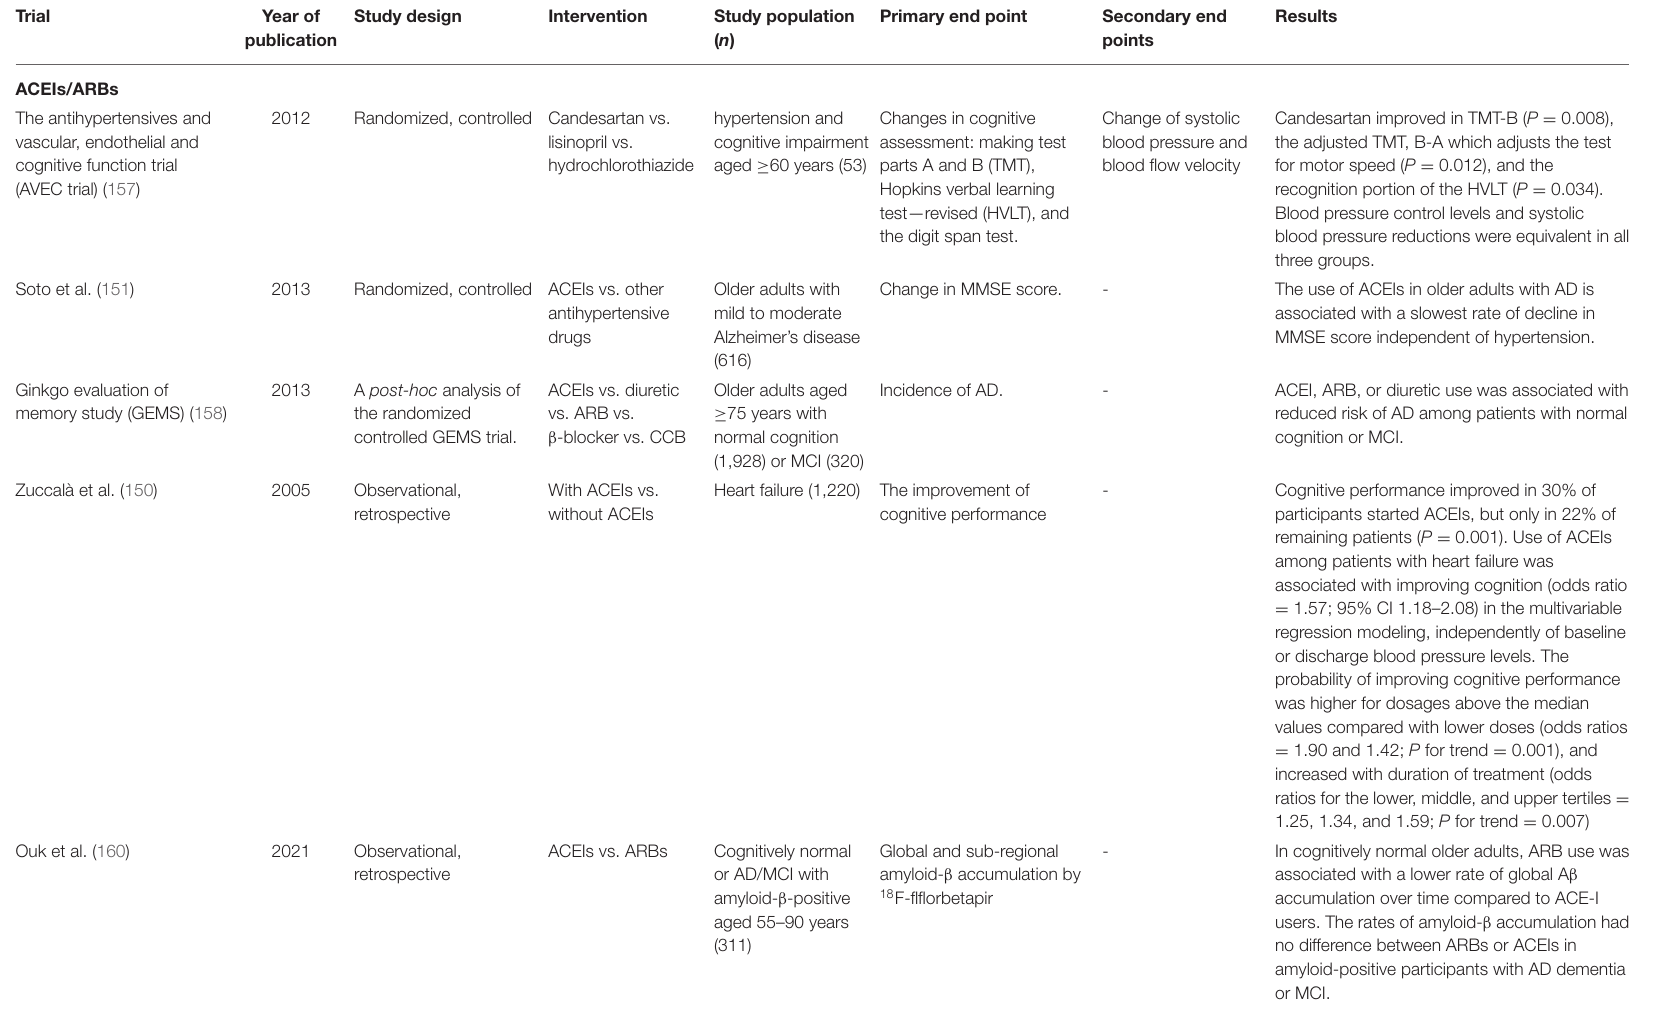
TABLE 2 | Summary of trials targeting medical treatment of cognitive impairment in heart failure (HF)